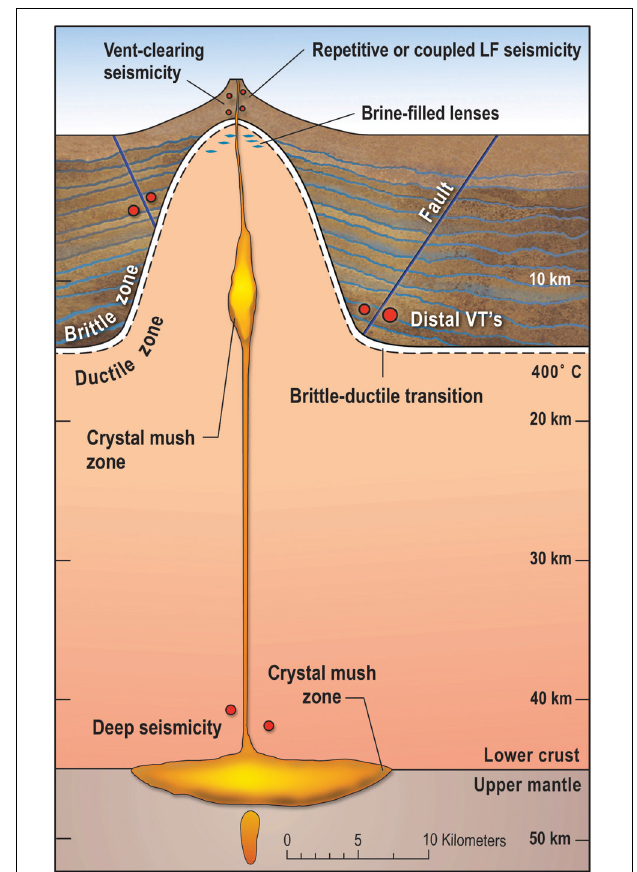
FIGURE 9 | Conceptual volcano model reproduced from McCausland et al. (2017), modified from a three-dimensional depiction to a two-dimensional one, and with additional modifications based on the work of Bachmann and Huber (2016) and Cashman et al. (2017). The first study proposed a process-based model that explains observed similarities in pre-eruptive seismic patterns at many arc volcanoes; the latter two studies emphasized the prevalence and importance of crystal-rich mush zones beneath magmatic systems. Together these concepts provide a useful framework for this paper’s discussion of activity at Mount St. Helens since its reawakening in